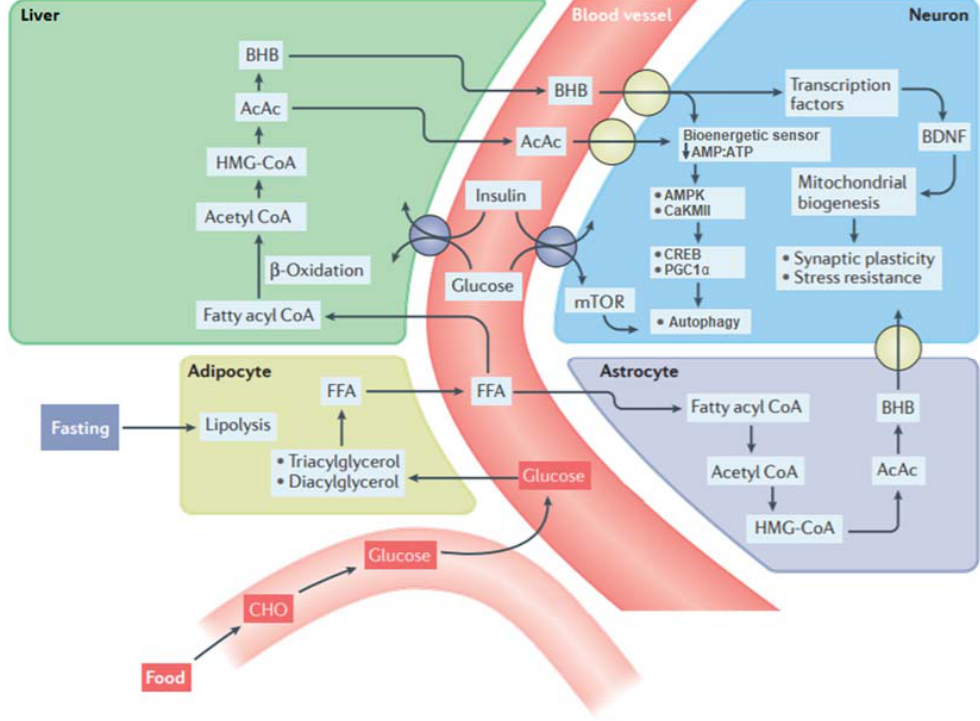
Figure 2. Biochemical pathways involved in the metabolic switch. During intermittent fasting, glucose levels drop and through the process of lipolysis, fats (triacylglycerols and diacylglycerols) are metabolized to free fatty acids (FFAs). These lipids are then transported to the liver where they through the process of β -oxidation and the intermediate stages acetyl CoA and HMG-CoA are transformed into the ketones: acetoacetate (AcAc) and β -hydroxybutyrate (BHB). BHB and AcAc are transported from the blood into the brain and then into neurons. In addition to ketones metabolized in the liver, astrocytes are also capable of ketogenesis, which may provide an important local source of BHB for neurons. The reduction in availability of glucose and elevation of ketones lowers the AMP: ATP ratio in neurons, which activates the kinases AMPK and CaKMII and, in turn, through the activation of CREB and PGC1 α stimulates autophagy. In addition, lower levels of glucose during fasting decrease the activity of the mTOR pathway, leading to autophagy. BHB can also upregulate the expression of brain-derived neurotrophic factor (BDNF) and may thereby promote mitochondrial biogenesis, synaptic plasticity, and cellular stress resistance. IF leads to lower levels of circulating insulin in the blood, which enhances neuroplasticity and protection against metabolic and oxidative stress through the insulin/IGF signaling pathway. Retrieved from [18] with small